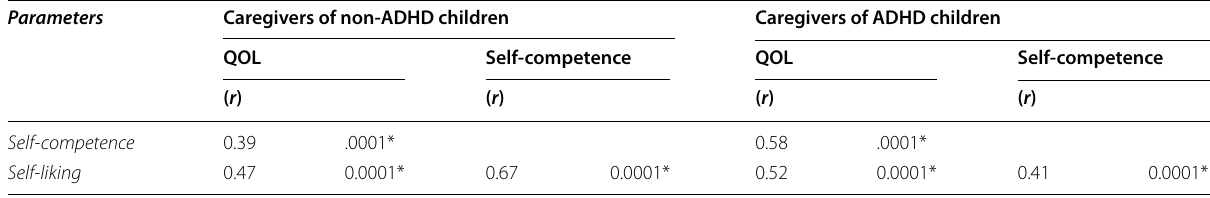
r correlation coefficient *Significant p <